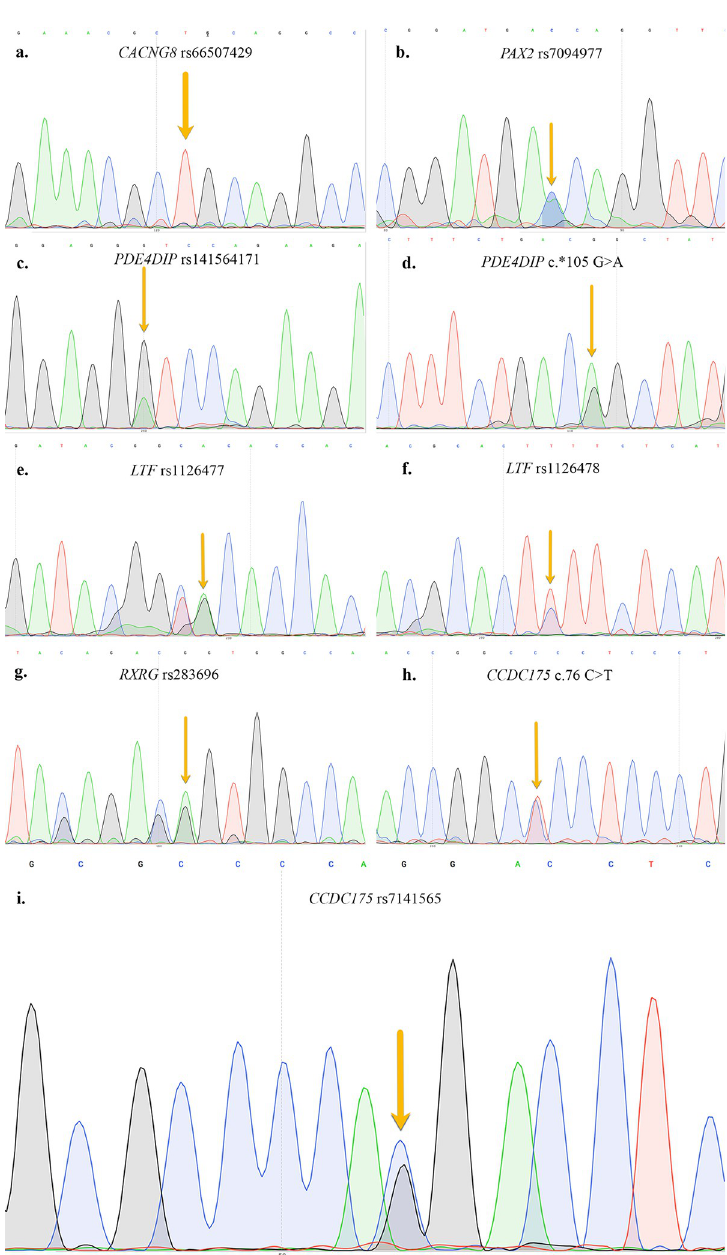
Fig 7. Sanger validation of final modifier gene candidate variants. All nine final selected variants carried by candidate modifier genes were validated by Sanger sequencing, and electropherograms are reported in figure. a–h, variants validated in proband; i validated in one proband’s